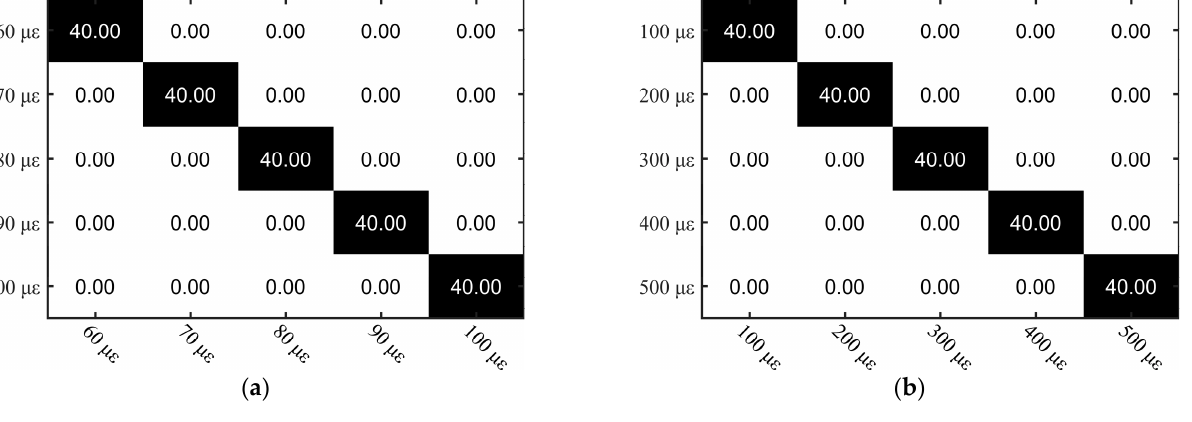
Figure 10. Confusion matrix of multilayer perceptron at strain from ( a ) 60 to 100 µε and ( b ) 100 to 500 µε .